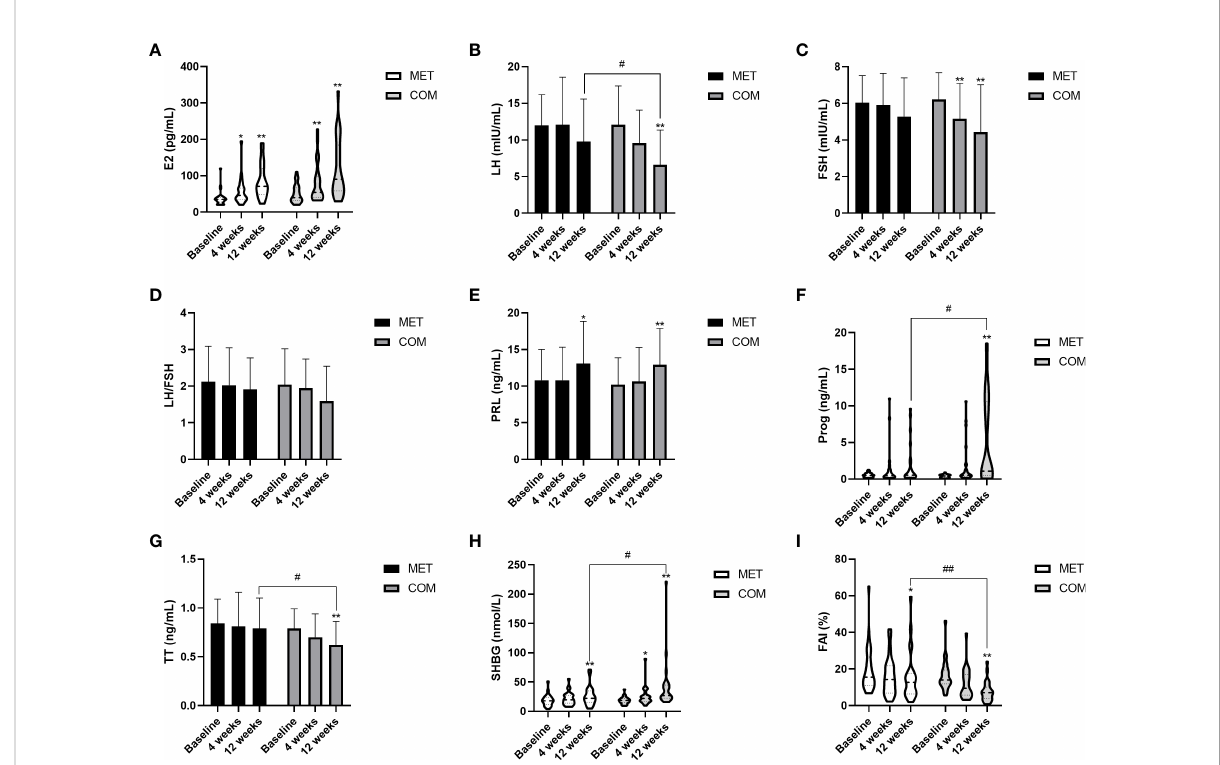
FIGURE 4 Changes in gonadal parameters after MET and COM therapy. (A) Changes in E2 after MET and COM therapy. (B) Changes in LH after MET and COM therapy. (C) Changes in FSH after MET and COM therapy. (D) Changes in LH/FSH after MET and COM therapy. (E) Changes in PRL after MET and COM therapy. (F) Changes in Prog after MET and COM therapy. (G) Changes in TT after MET and COM therapy. (H) Changes in SHBG after MET and COM therapy. (I) Changes in FAI after MET and COM therapy. MET, metformin; COM, combine; E2, estradiol; LH, luteinizing hormone; FSH, follicle-stimulating hormone; PRL, prolactin; Prog, progesterone; TT, total testosterone; SHBG, sex hormone-binding globulin; FAI, free androgen index. Results are expressed as mean ± SD or median (25 th – 75 th percentile); * P < 0.05, ** P < 0.01 (vs. before treatment in each group); # P < 0.05, ## P < 0.01 (vs. the other